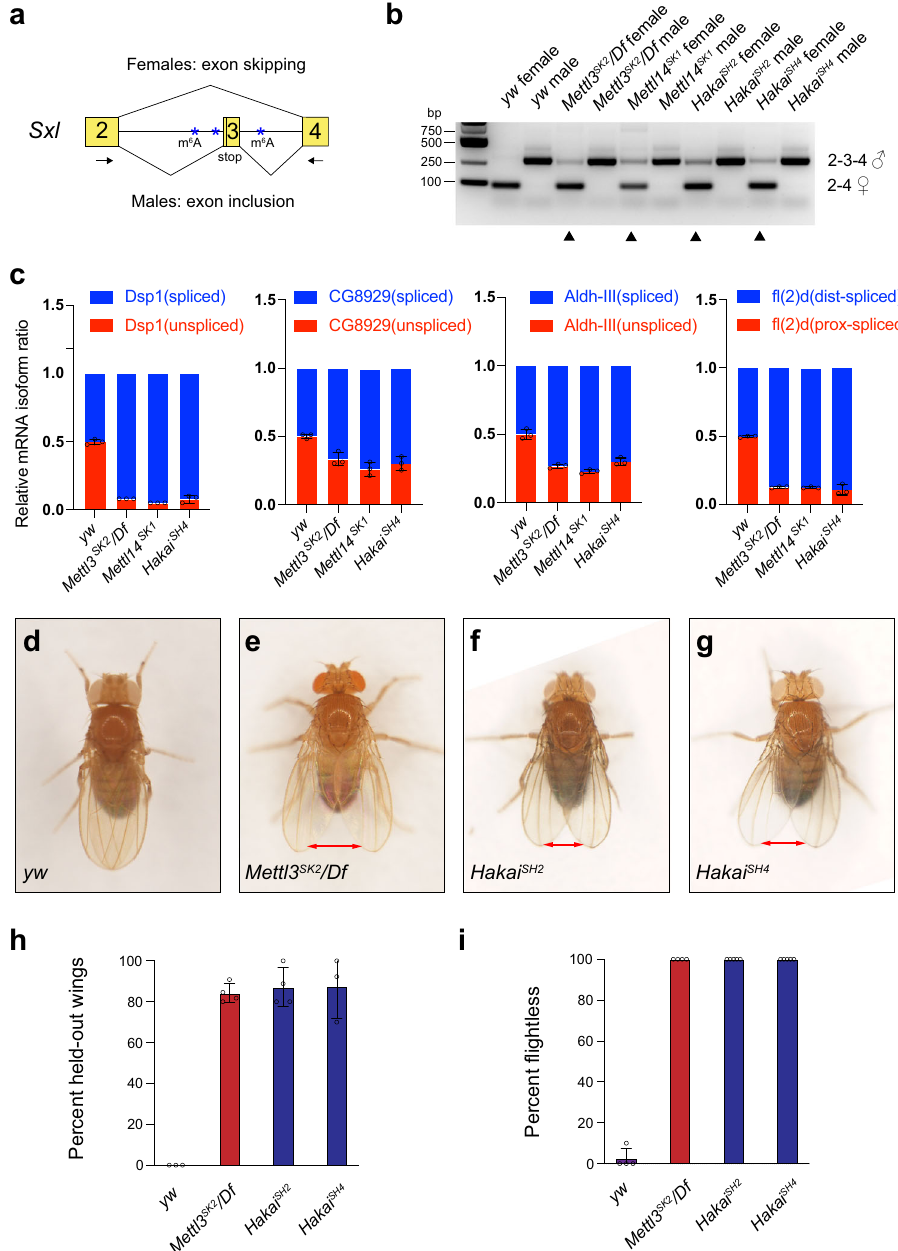
Fig. 3 Hakai regulates Sxl alternative splicing and adult fl y behavior. a Diagram showing the alternative splicing event that produces male- or female- speci fi c Sxl transcripts. The arrows indicate primers used for RT-PCR. b Sxl splicing was analyzed by RT-PCR using RNAs extracted from adult fl ies of indicated genotypes. Note the appearance of male-speci fi c bands in Mettl3 SK2 /Df , Mettl14 SK1 , Hakai SH2 , Hakai SH4 females (arrowheads). Male-speci fi c bands: 2 – 3 – 4. Female-speci fi c bands: 2 – 4. c Relative isoform quanti fi cation for Dsp1 , CG8929 , Aldh-III and fl (2)d by qPCR in control or m 6 A mutant fl ies. Hakai is involved in m 6 A-dependent splicing events. Data are presented as mean ± SD from three biological replicates. d yw fl ies have their wings properly folded. ( e ) Mettl3 SK2 /Df , ( f ) Hakai SH2 , ( g ) Hakai SH4 fl ies cannot fold their wings and exhibit a held-out wing phenotype (marked by the double arrows). The frequency of fl ies showing held-out wings were quanti fi ed in ( h ). i Flies of the indicated genotypes were tested for their fl ight abilities, and the number of fl ightless fl ies was quanti fi ed. All fl ies used from ( c ) to ( i ) were males. h – i Data are presented as mean ± SD from three to fi ve biologically independent groups ( h , n = 3, 4, 4, 3; i , n = 4, 4, 5, 5). Source data are provided as a Source Data fi